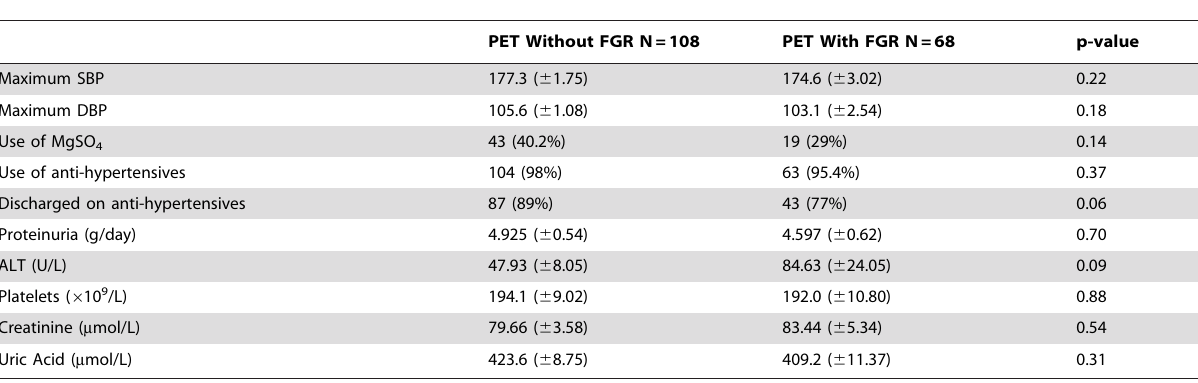
Table 2. Pre-eclamptic